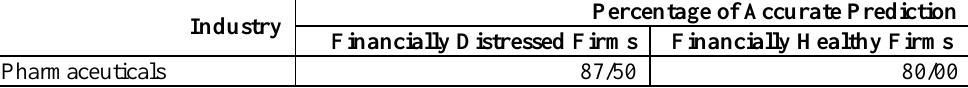
Table (12). Accuracy of Final Model for Predicting Corporate Default in the Group of Financially Distressed and Healthy